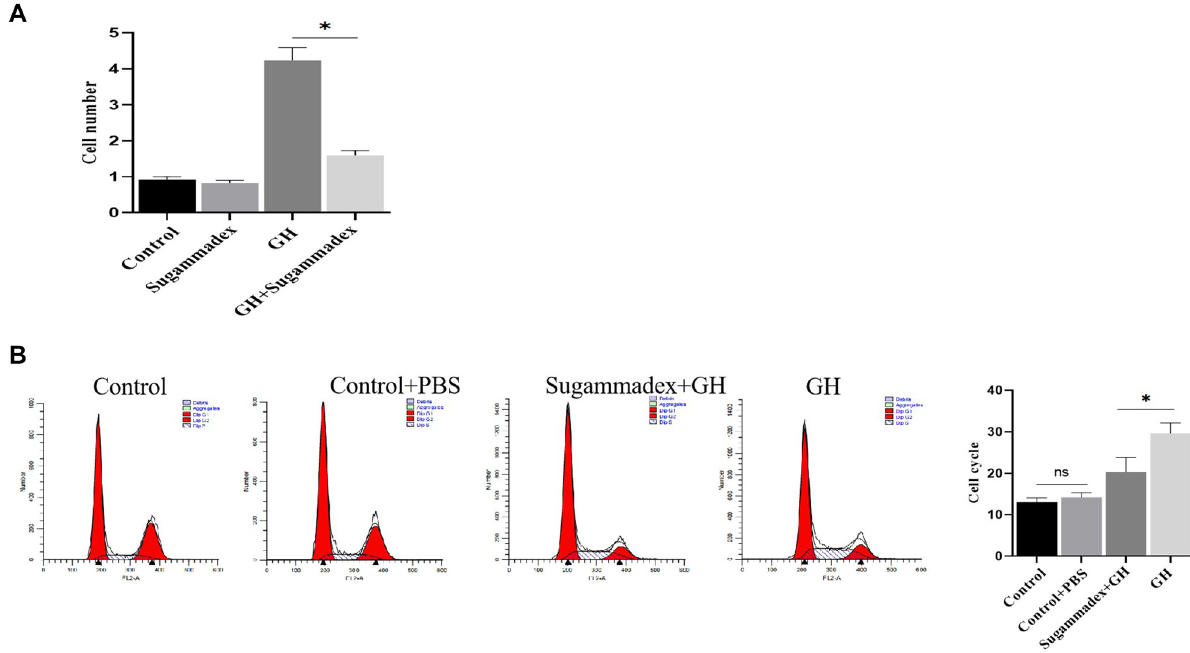
Figure 1: (A) Sugammadexinhibited GH ’ s biological activity.Growth hormone (GH)-induced cell proliferationwas significantly suppressed by Sugammadex treatment. (B) Sugammadex influences the cell cycle induced by GH. Data are represented as mean ± standard deviation (SD). The asterisk indicates that the difference is statistically signi fi cant (p-value